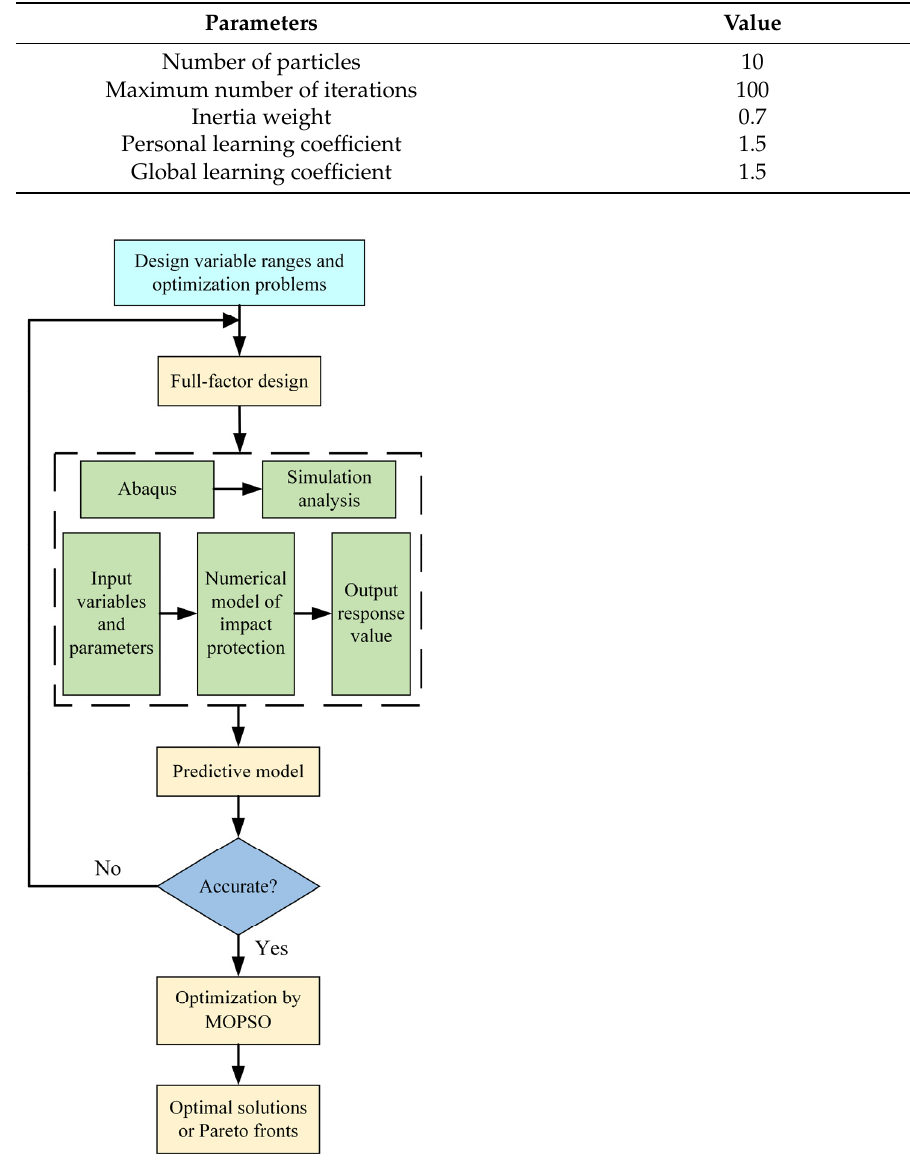
Table 3. Parameters of particle swarm algorithm.